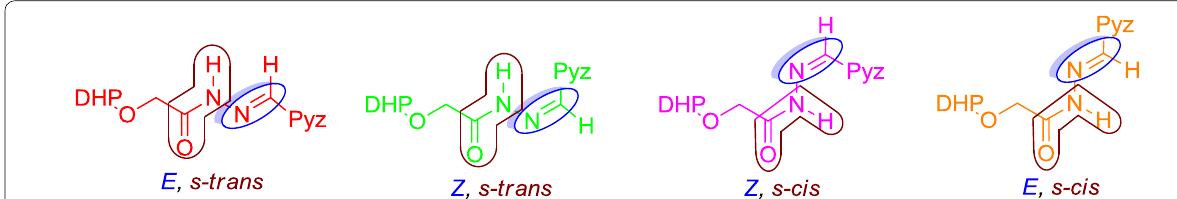
Fig. 2 Four possible isomeric form for 5a